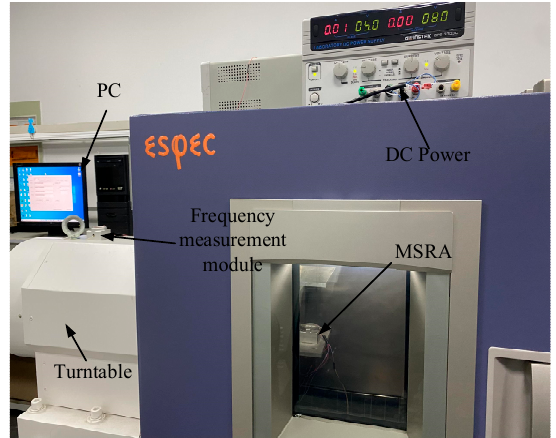
Figure 9. The testing environment.